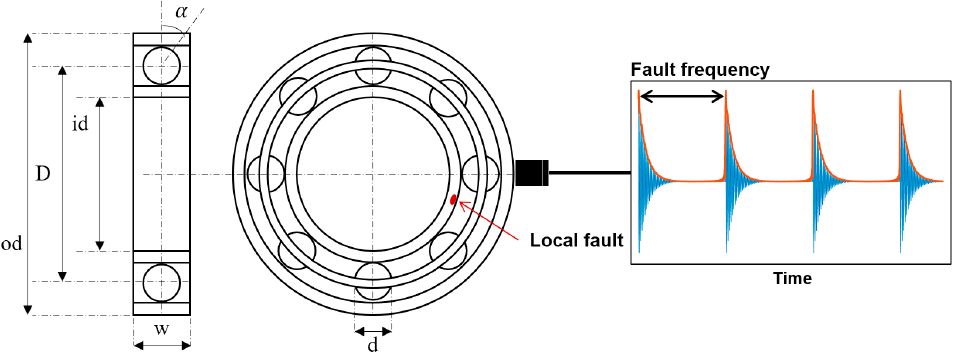
Figure 1. Bearing geometry and impact signal.